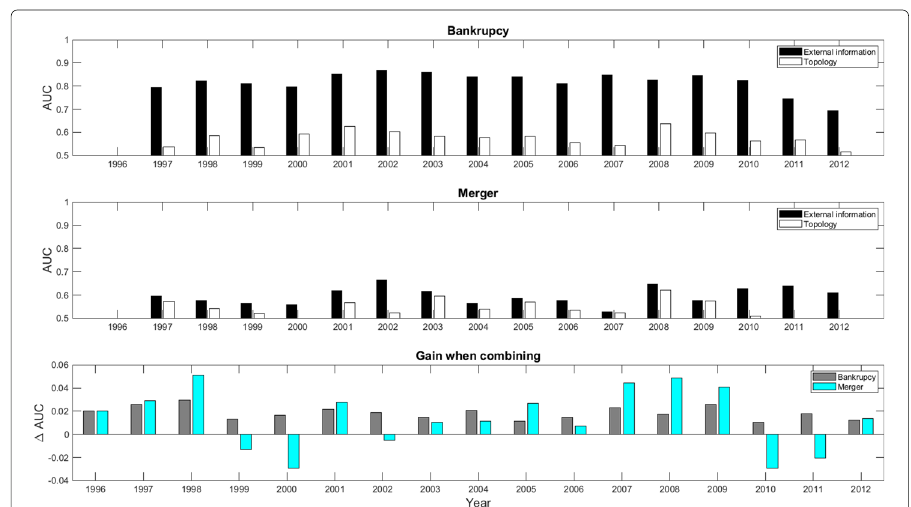
Fig. 11 The same as Fig. 10, but for predicting the next